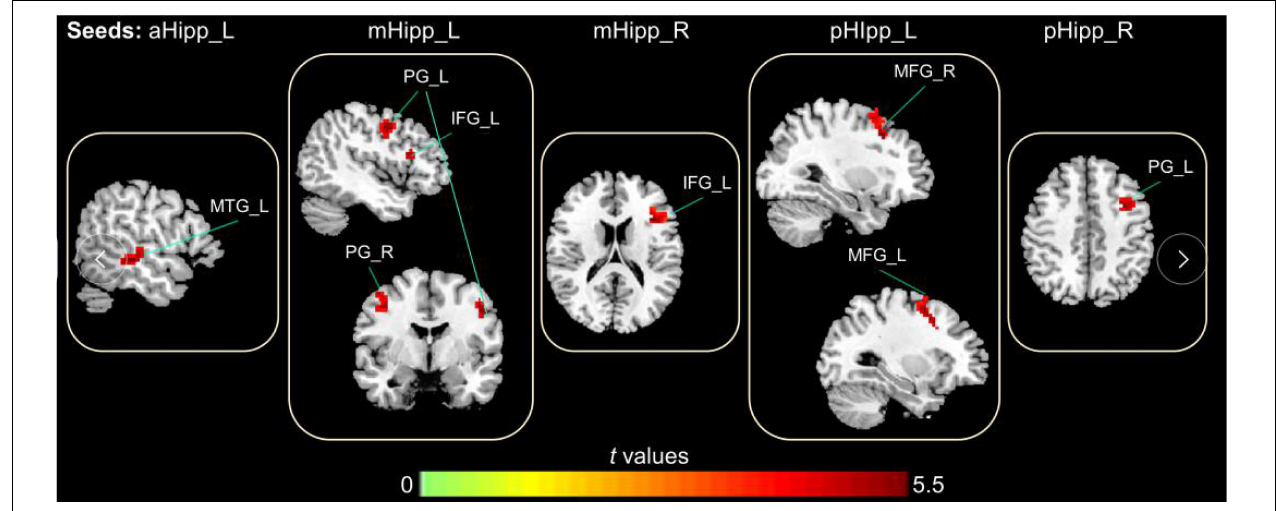
FIGURE 3 | The abnormal FC in the hippocampal subdivision of OSA, the increased FC in OSA group compared to GSs group (Warm color); Gaussian Random-Field corrected; voxel level: p < 0.005; cluster volume > 10